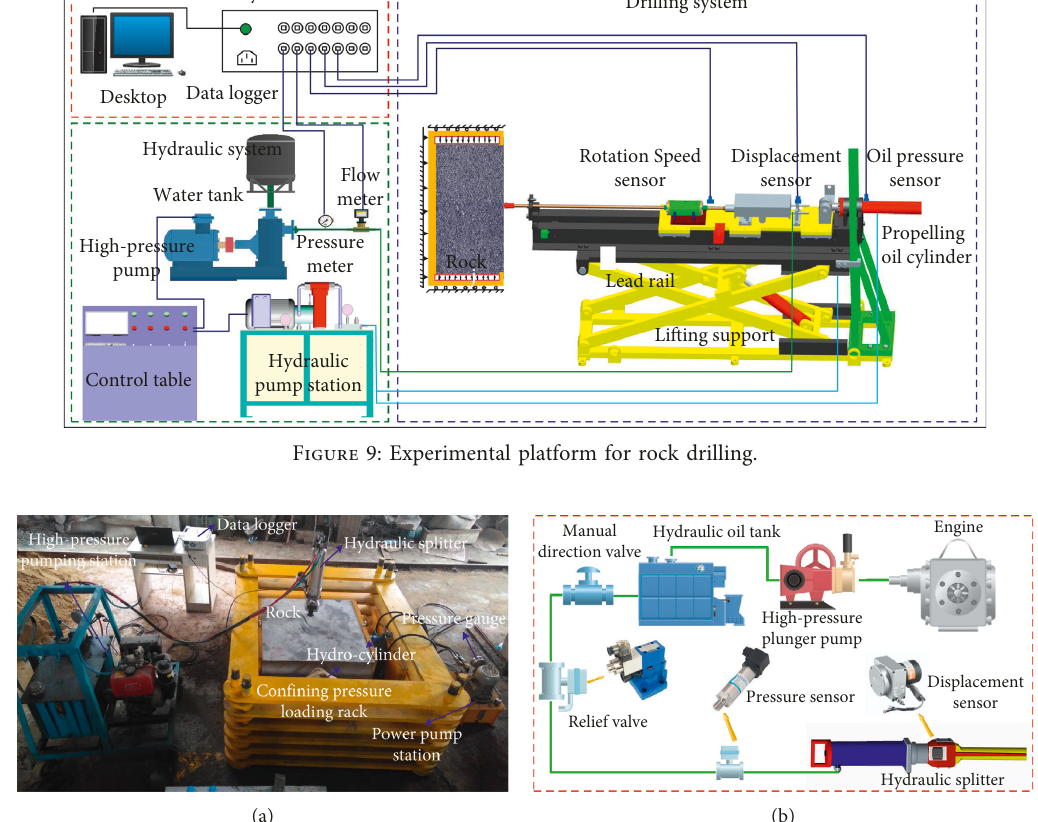
Figure 10: Experimental device and principle diagram of rock splitting.